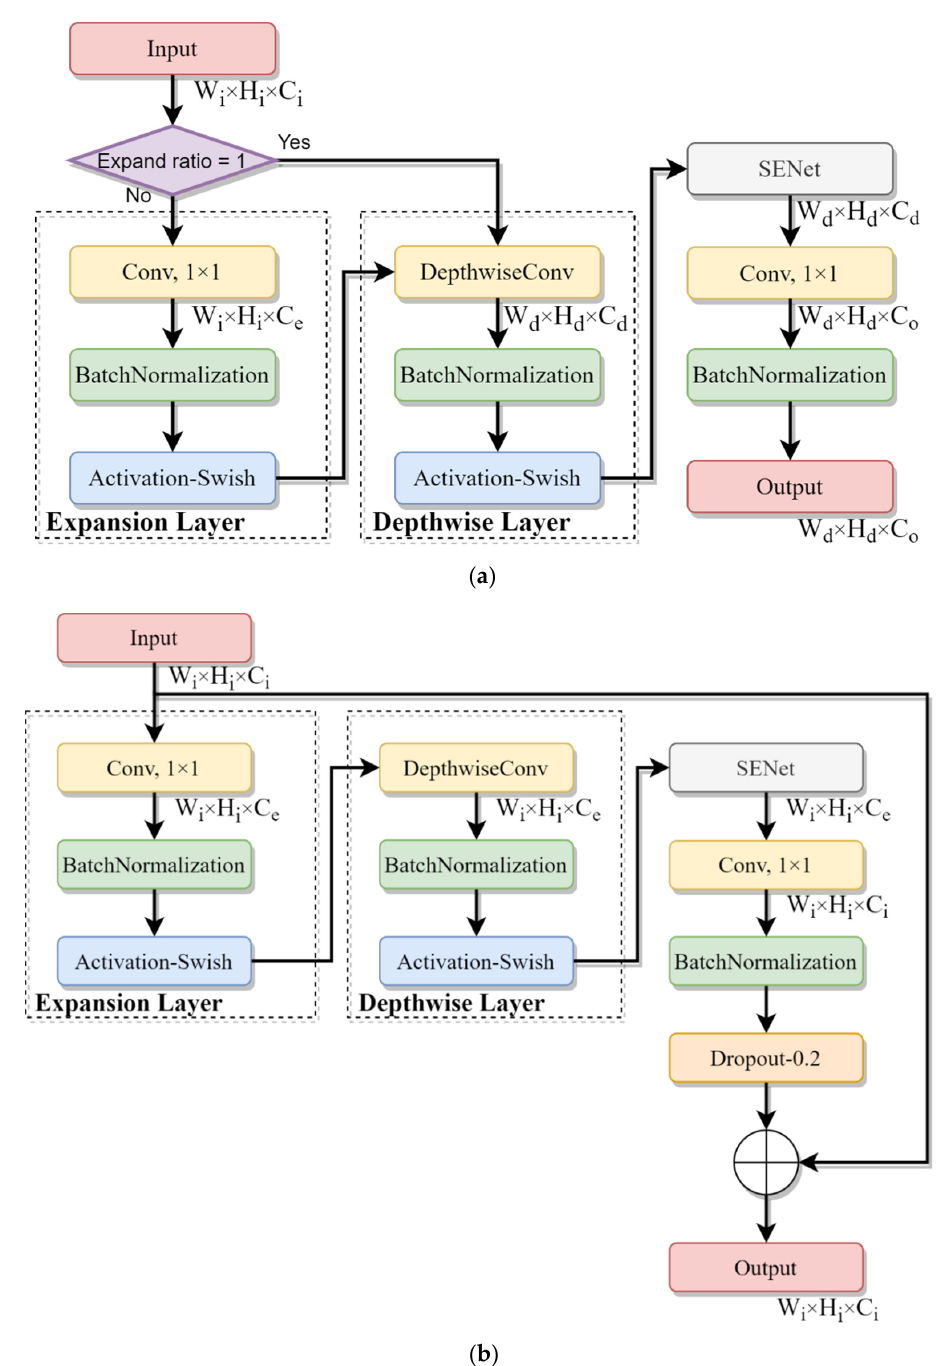
Figure 6. Flowcharts of ( a ) the MBConv-A block and ( b ) the MBConv-B block.